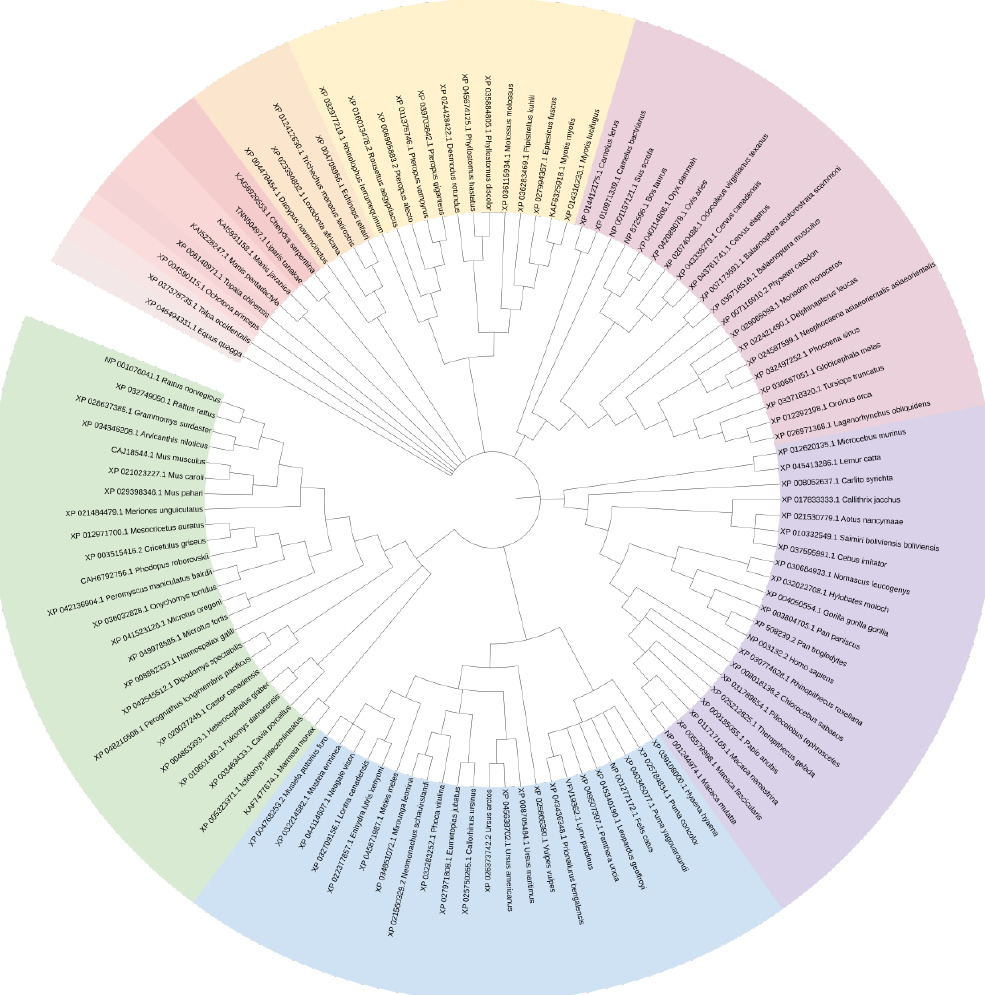
Figure 2. Genetic analysis of TRIM21 among different species. Amino acid sequences of porcine TRIM21 were compared with those of 112 other species using MEGA 11.